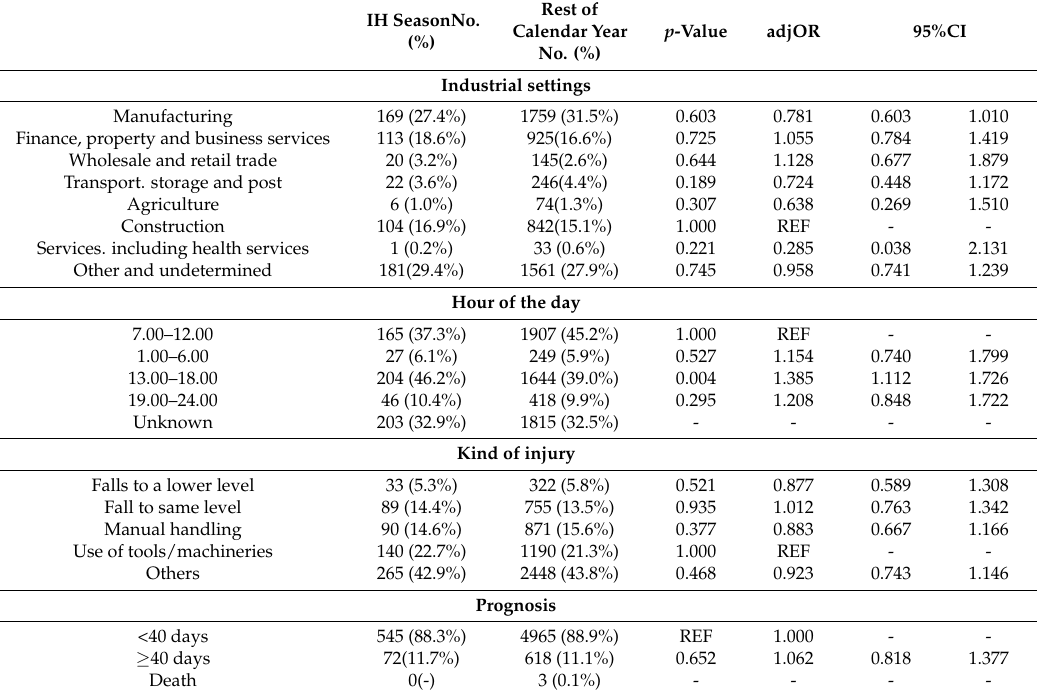
Table 4. Comparison of prevalence rates for OIs in EMRO workers by settings of the injury and time period, i.e., occurring in the Islamic holiday time-period (IH) vs. non IH. IH SeasonNo.